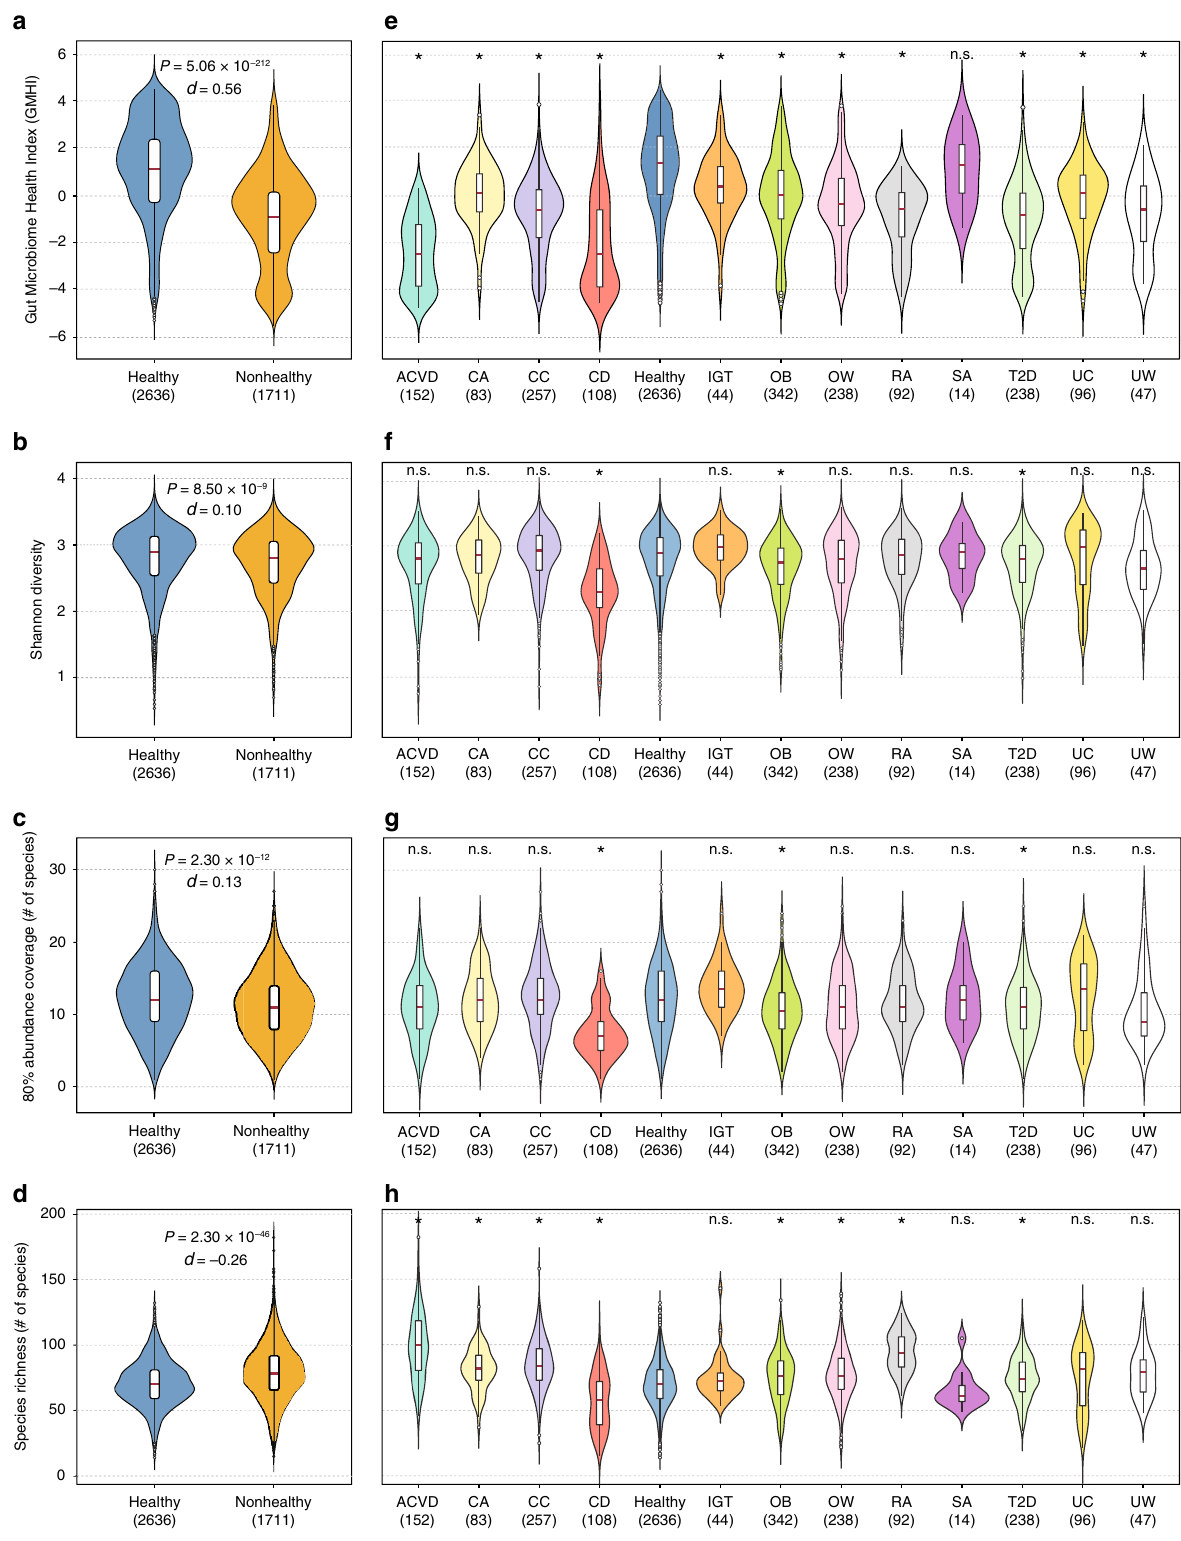
and nonhealthy stool metagenome groups (selected based on their GMHIs) clearly clustered apart from each other in PCoA ordination (Supplementary Fig. 7), in stark contrast to the case when all samples were projected simultaneously (Fig. 1c). These observations con fi rm that very high (or low) collective abundance of Health-prevalent species relative to that